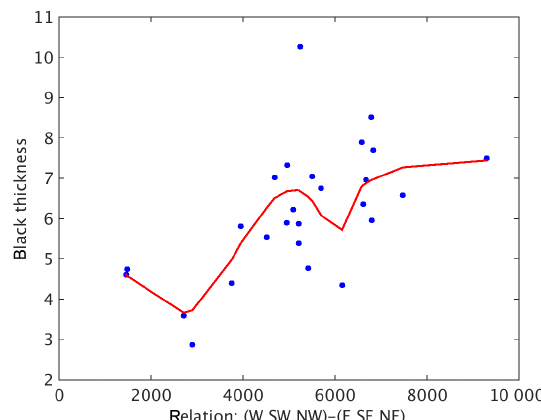
Figure 8. Scatterplot of the difference between the number of west- erly (W, SW, and NW) and easterly (E, SE, and NE) winds and the black layer thickness. The red line shows the smoothing with a loess filtering (see Sect.